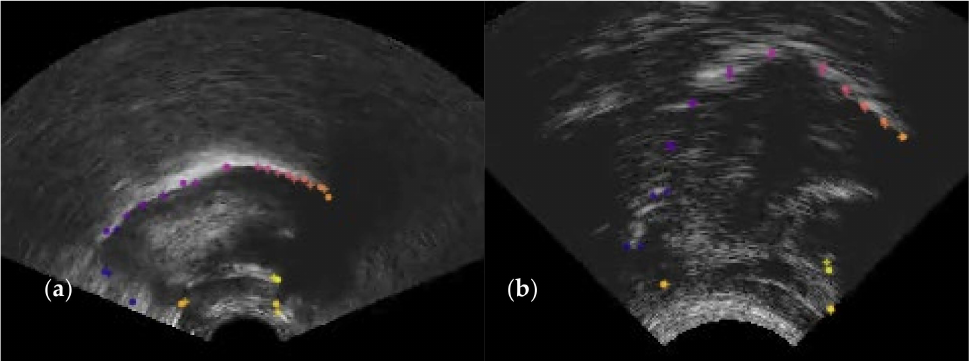
Figure 6. ( a ) Shows points estimated to lie on the tongue surface but distributed differently to the hand labels; ( b ) an example where the positions are estimated accurately. ‘+’ indicates the estimated